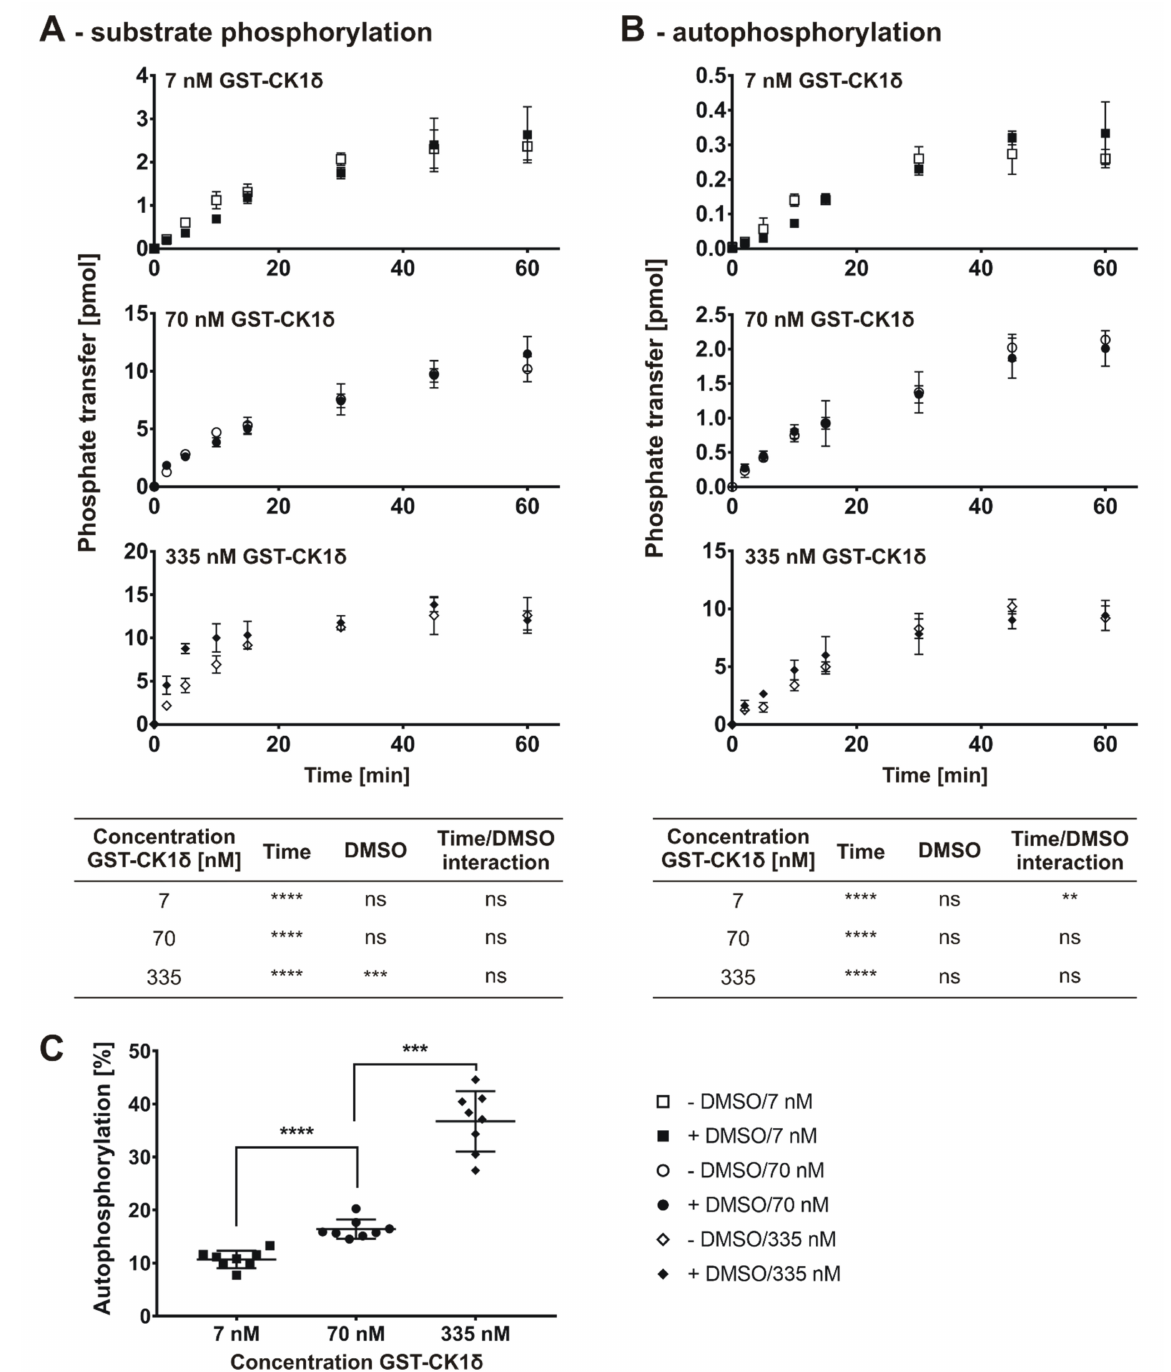
Figure 3. Product-over-time progression curve for GST-tagged CK1 δ autophosphorylation and substrate phosphorylation. ( A ) Time-dependent phosphate transfer from [ γ - 32 P]-ATP to the substrate α -casein catalyzed by human recombinant GST- tagged CK1 δ using different enzyme concentrations (7, 70, 335 nM) was determined by in vitro kinase reactions in absence and presence of solvent (+/ − DMSO). ( B ) Time-dependent autophosphorylation of GST-CK1 δ has been determined and is presented similar to data shown in ( A ). ( C ) The mean proportional autophosphorylation relative to total phosphorylation (cumulated time-points) is significantly increased at higher enzyme concentrations. Statistical significance was tested using two-way ANOVA (for data presented in ( A , B )) and unpaired two-tailed t -test ( C ). ns indicates p > 0.05, ** indicates p ≤ 0.01, *** indicates p ≤ 0.001, **** indicates p ≤ 0.0001. DMSO, dimethyl